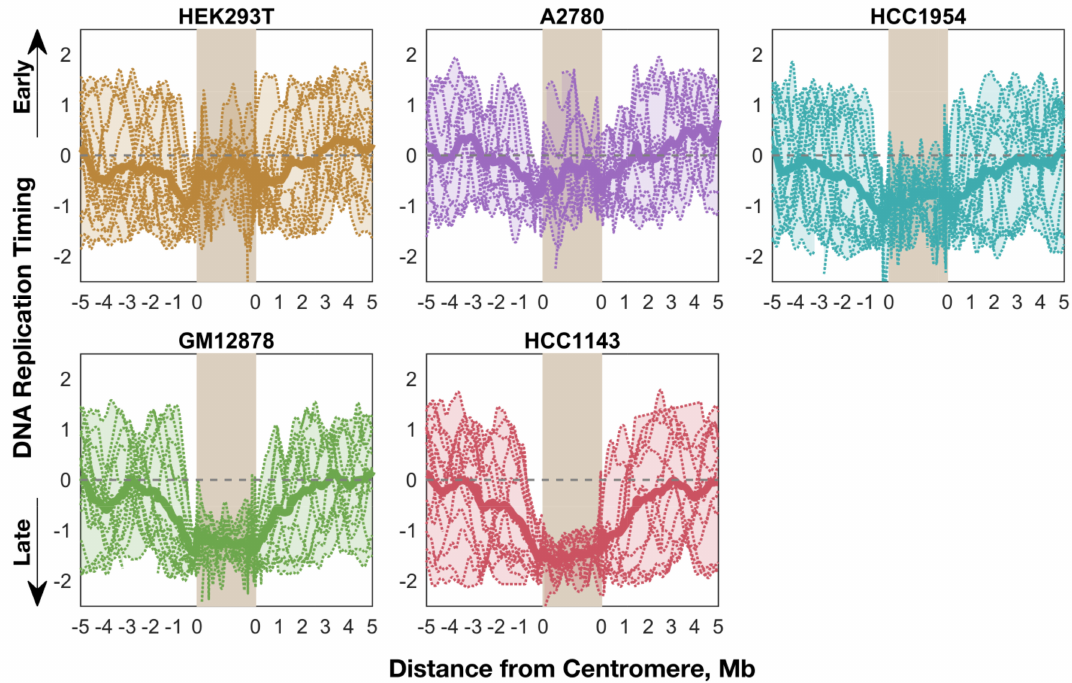
Figure 4. Average replication timing is more consistent within the centromeres of a given cell line than in the surrounding pericentromeres (or the whole genome). For each cell line, the replication timing profile for each mappable centromere (see Figure 1) is shown, overlaid with an averaged “aggregate” profile for that cell line’s centromeres. The shaded area indicates the minimum and maximum values, and the dashed line indicates the genome average. Each centromere was divided into 100 bins for the purpose of